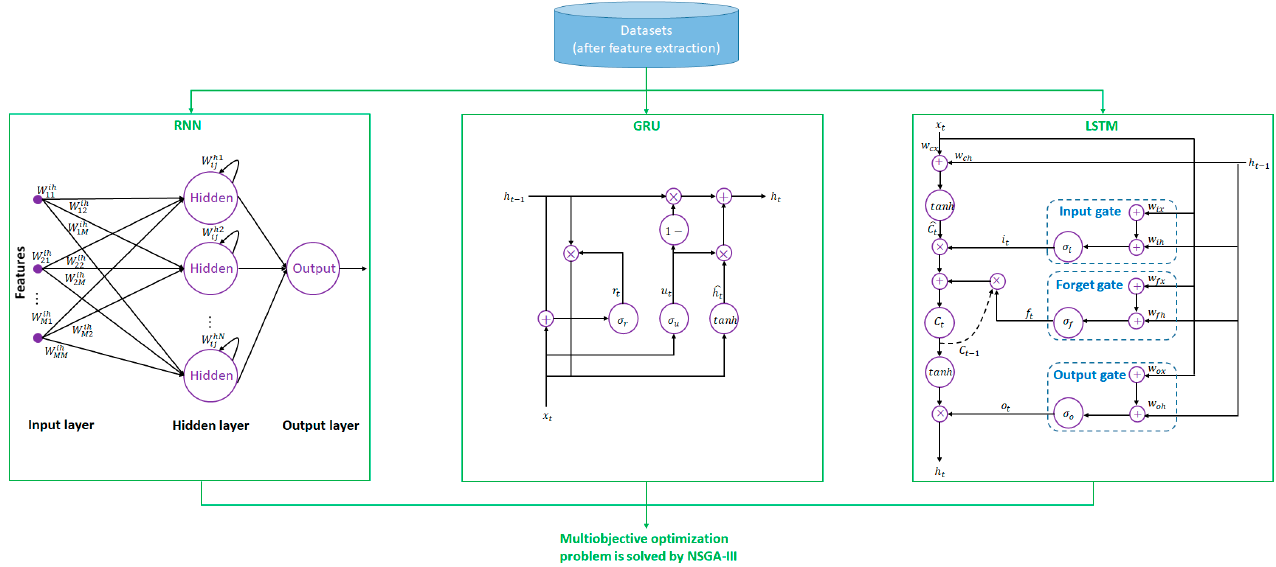
Figure 2. Conceptual diagram of the recurrent neural network (RNN), gated recurrent unit (GRU), and long short-term memory (LSTM) algorithms.